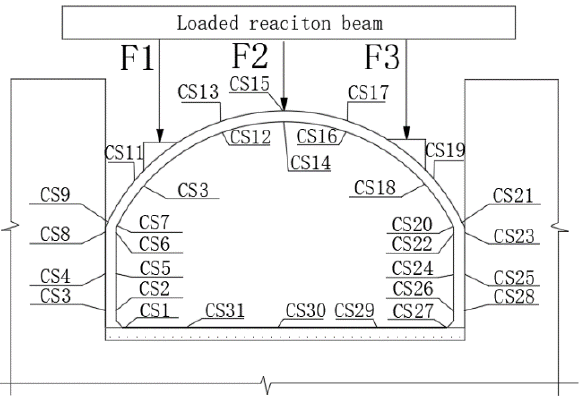
Figure 7. Strain measuring points. F1 is the loading point at the arch quarter span; F2 is the loading point at the midpoint of the arch; F3 is the loading point at the three-quarter arch span; CS1-CS28 are strain measuring points at different positions of the lining structure.